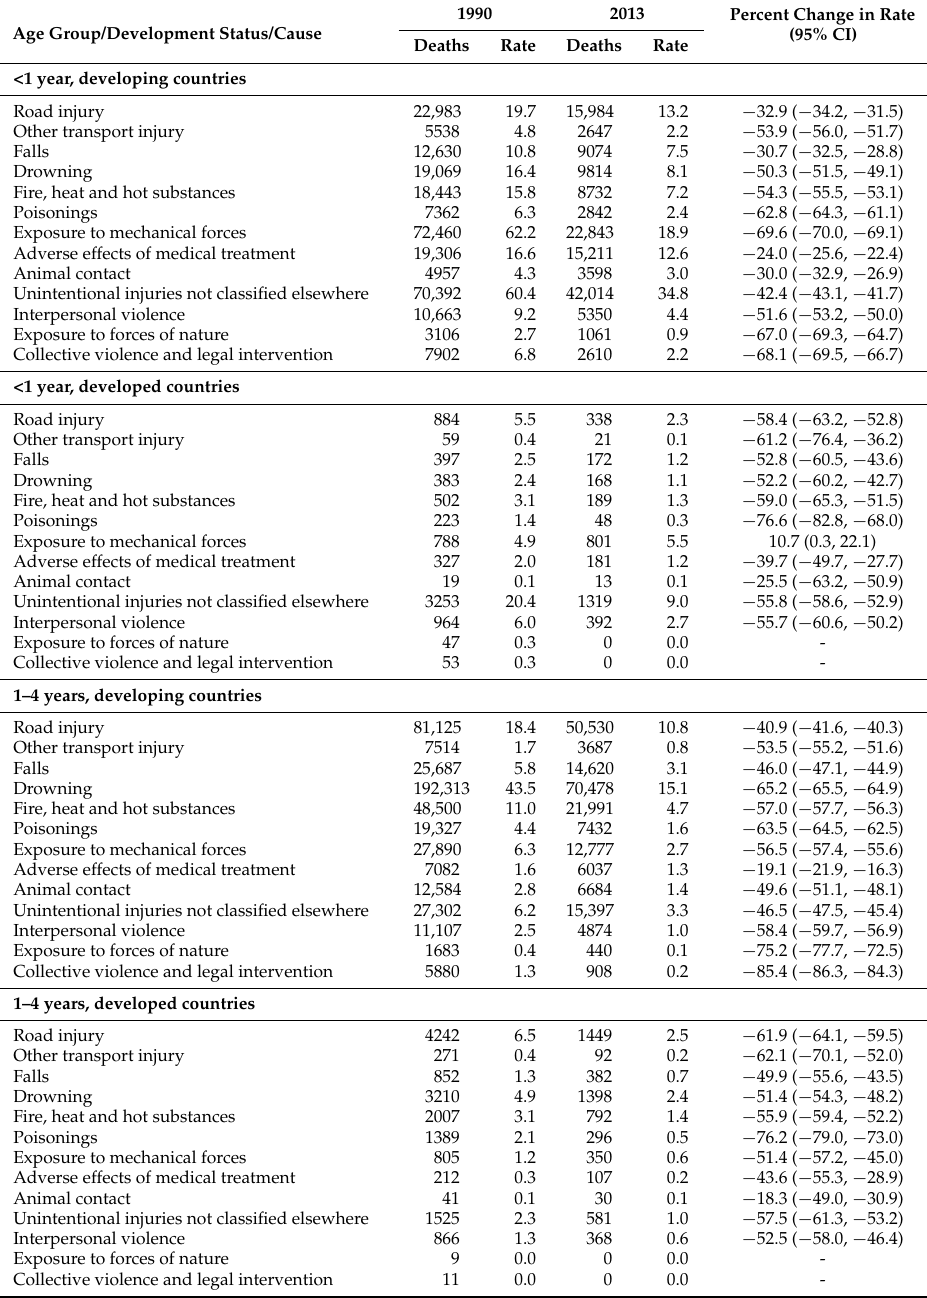
Table 1. Change in cause-specific injury mortality (/100,000 persons) among under-five children between 1990 and